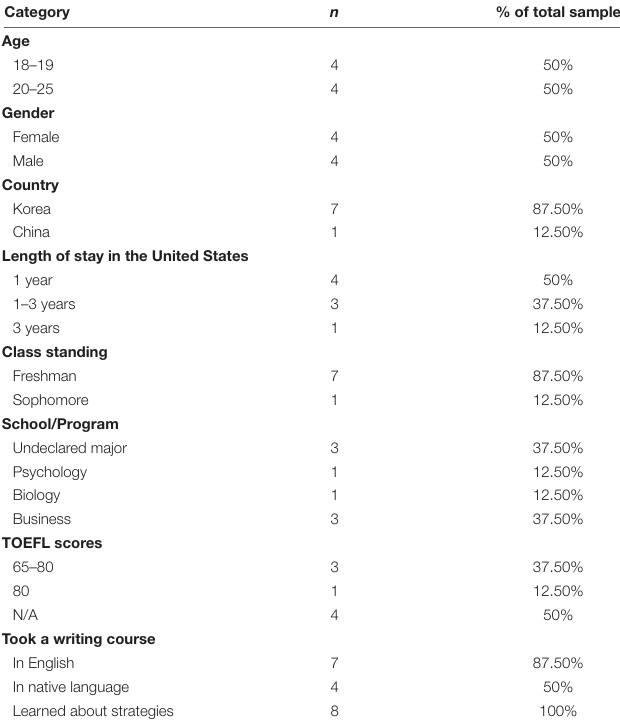
TABLE 1 | Sample demographics ( n =